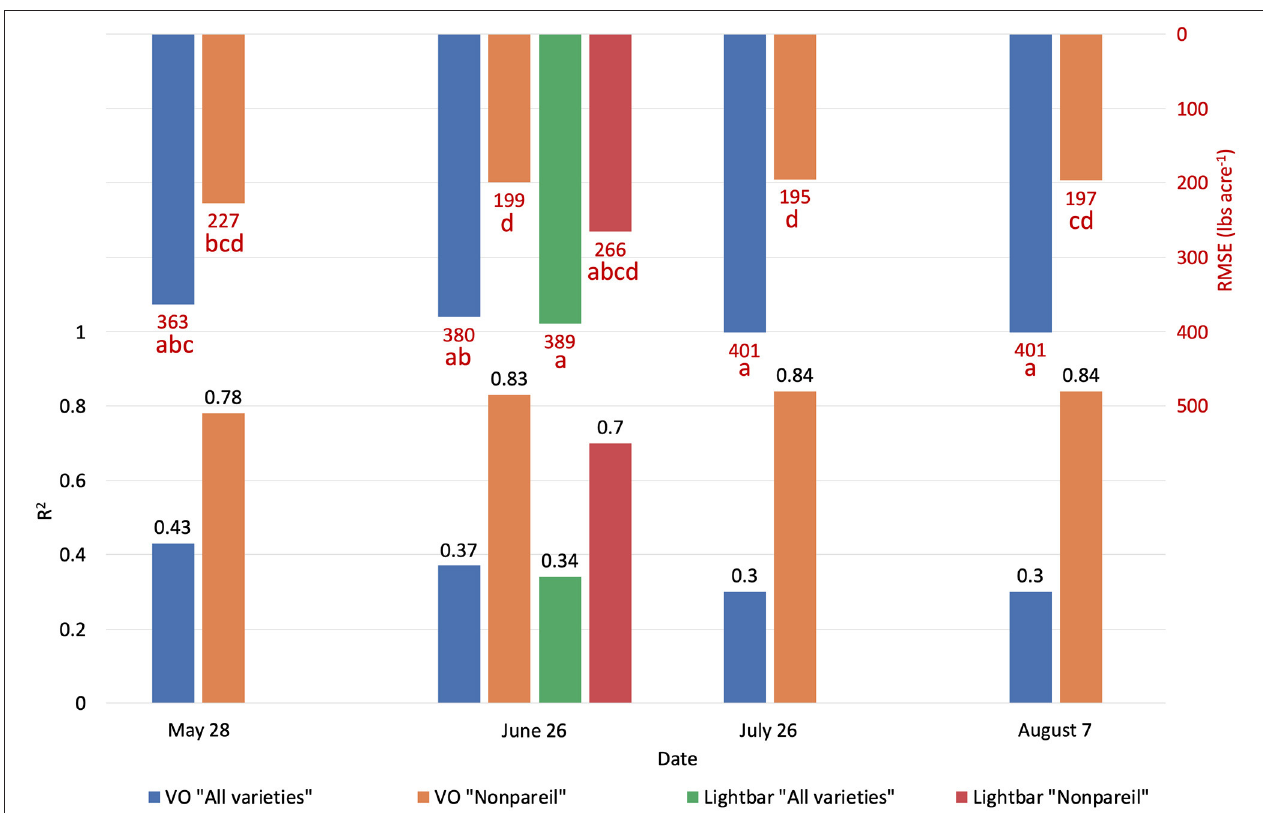
FIGURE 6 | Comparison of R 2 and root mean square error (RMSE) (to regression line) between Virtual Orchard (VO) and the mobile lightbar platform estimated canopy Fractional PAR (fPAR) and actual almond kernel yield for all varieties and ‘Nonpareil’ only over the season in 2019 at the per-row level. Different letters refer to a statistically significant difference testing the means of absolute errors in predicting actual almond yield with different regression models using analysis of variance (ANOVA) multi-comparison ( p <